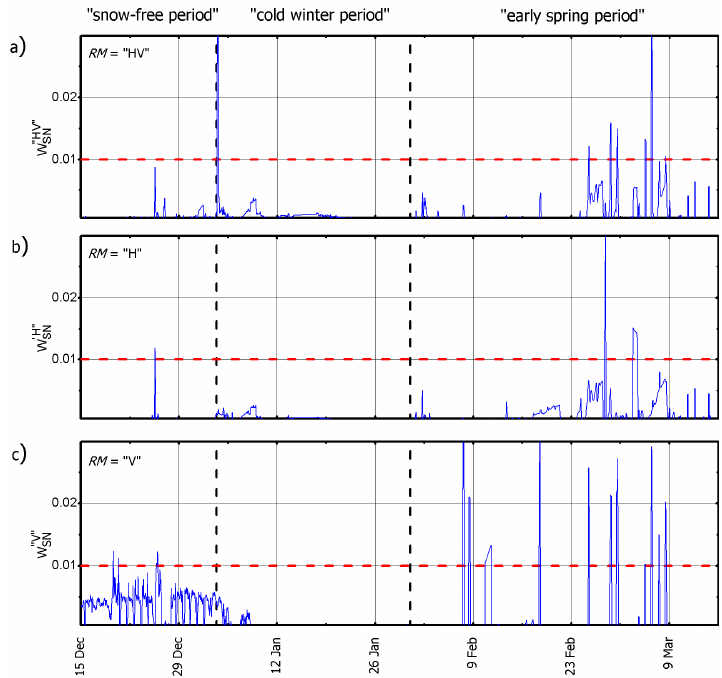
Figure 7. ( a – c ) show snow liquid water (cid:1849) (cid:2903),(cid:2898)(cid:3019)(cid:3014) retrievals using (cid:1846) (cid:2886),(cid:2898)(cid:3043) ((cid:2016) (cid:3038) ) for RM = “HV”, “H”, and “V”, respectively. The retrievals are shown for the snow-covered period from 8 January to 15 March The horizontal dashed red lines indicate the (cid:1849) (cid:2903) = 0.01 m (cid:2871) m (cid:2879)(cid:2871) threshold as the rough moist-snow approximation.